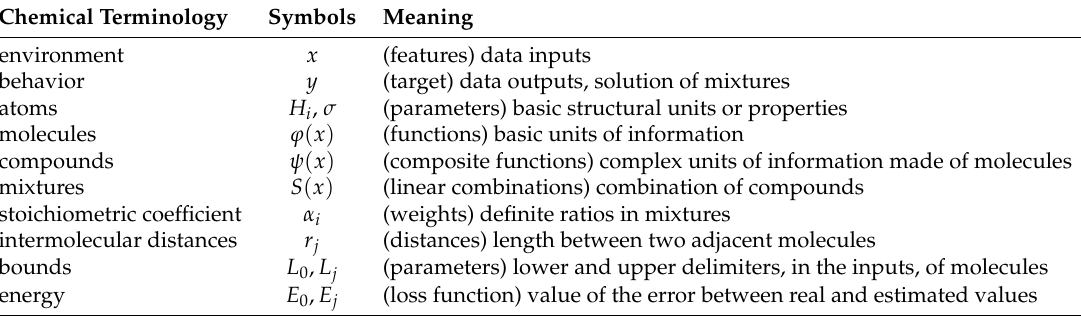
Table 1. Description of the chemical terms used in artificial hydrocarbon networks.